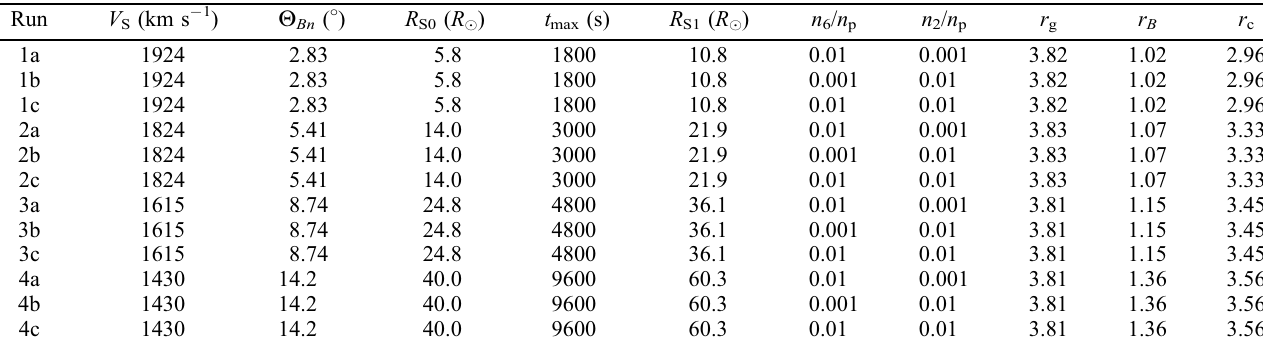
Table 1. Simulation parameters. The first column gives the label of the run, the second column the shock-normal speed, the third the shock- normal angle, the fourth the initial position of the shock, the fifth the simulation time, the sixth the final distance of the shock, the seventh and eight columns the parametrisation of the seed population, the ninth and tenth columns give the shock’s gas compression ratio and magnetic compression ratio and the eleventh column its scattering-centre compression ratio.